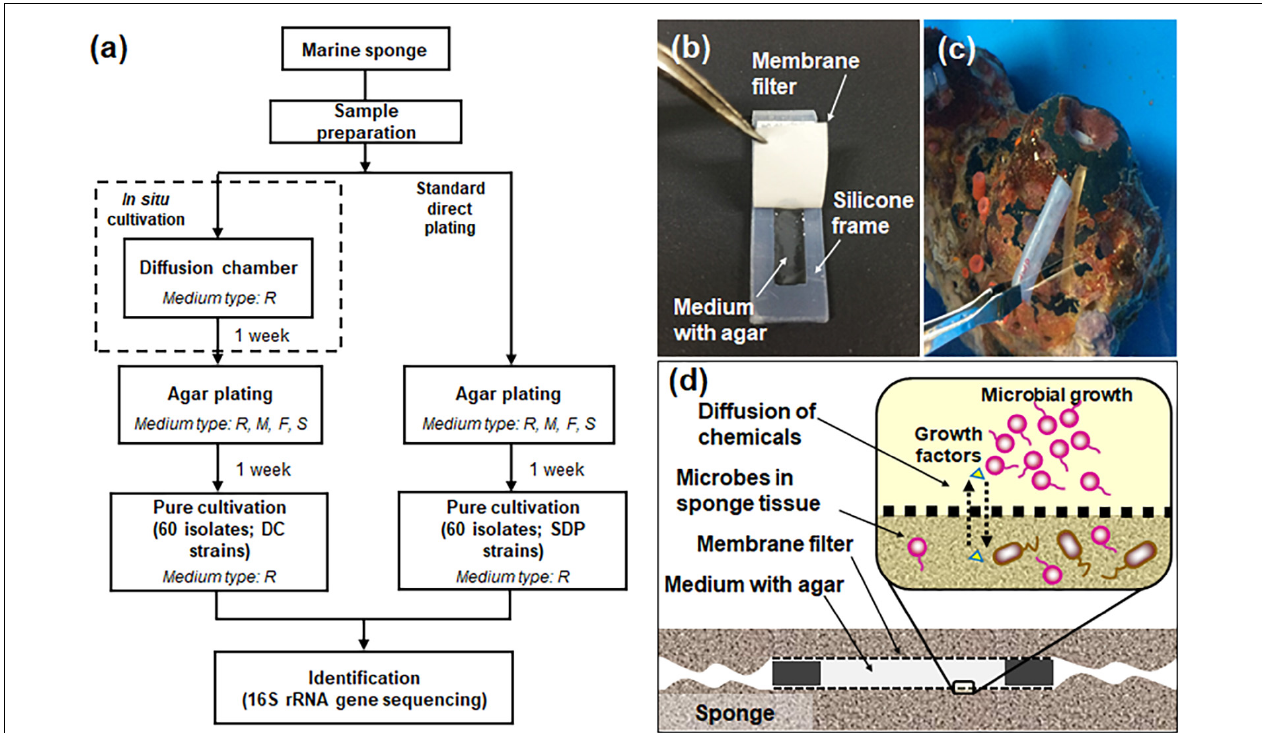
FIGURE 1 | Flowchart of the experimental steps for microbial cultivation from marine sponges (a) and the diffusion chamber (DC) cultivation method used in the present study: a photo showing the structure of the chamber (b) , a photo showing installation of the DC device into the marine sponge (c) , a schematic image showing the principle of DC (d) . The letters R, M, F, and S in (a) refer to used media, 1/10 diluted R2A, Marine, Fish extract, and Sponge extract medium. See the experimental procedures for explanation of the different media used.